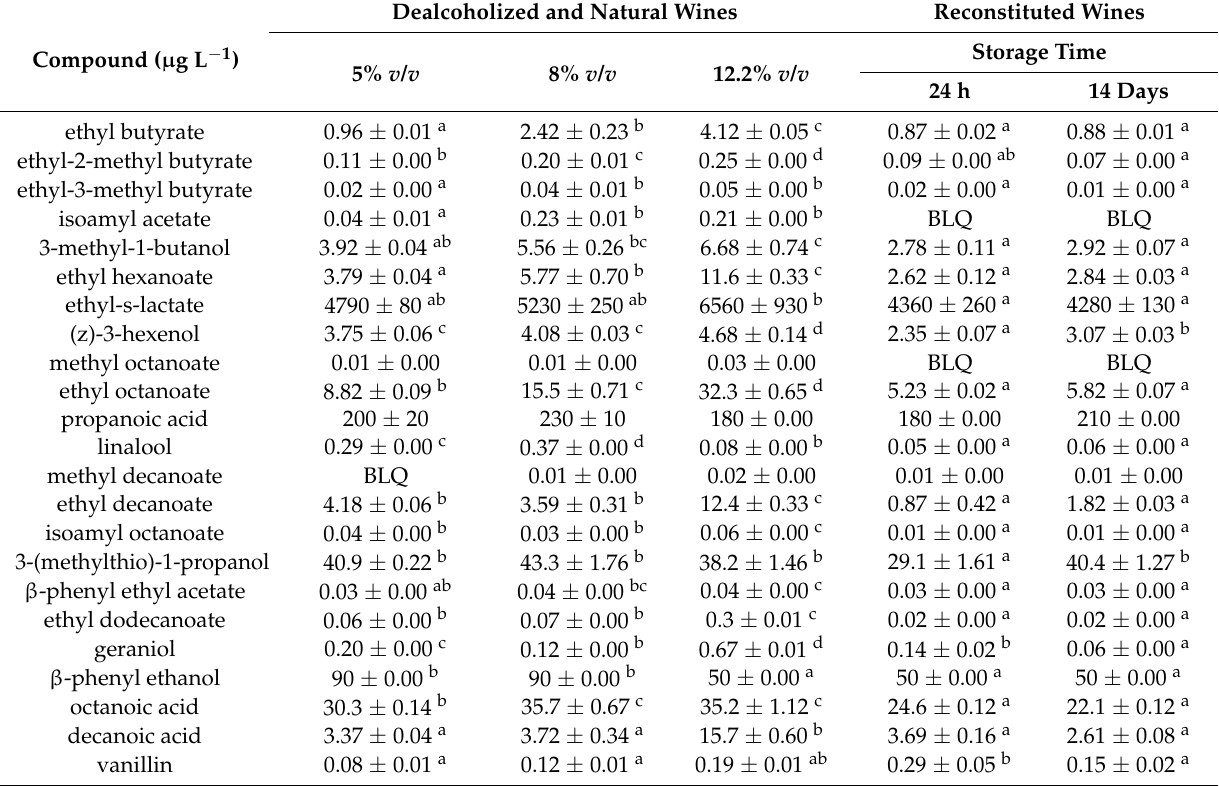
Table 4. The changes in the headspace concentration of volatile compounds in Chardonnay